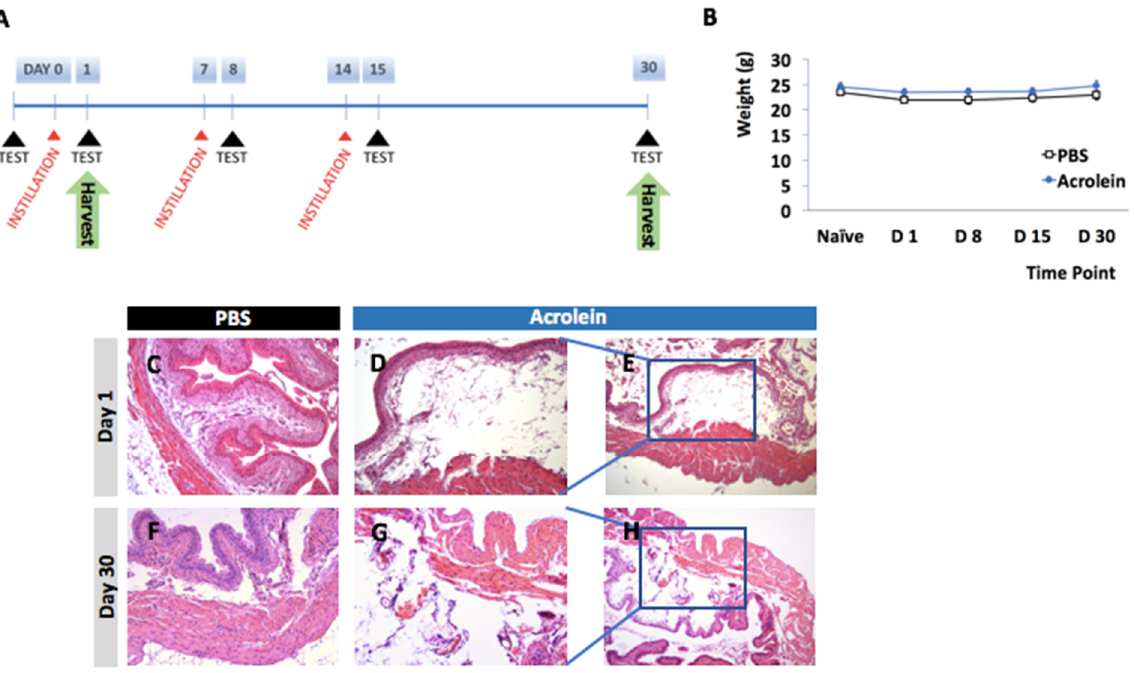
Figure 2. Murine model of a repeated low-dose of acrolein-induced lamina propria in urinary bladder. ( A ) Experimental design to study the effects of the three-time transurethral instillation of 10 µg acrolein and 15-day treatment-free period on the urinary bladder of adult C57BL6/J mice. ( B ) Changes in body weight of mice in the PBS group (PBS mice) and acrolein group (acrolein group). ( C – H ) Representative images of hematoxylin and eosin (H&E)-stained images of the urinary bladders of PBS and acrolein mice.